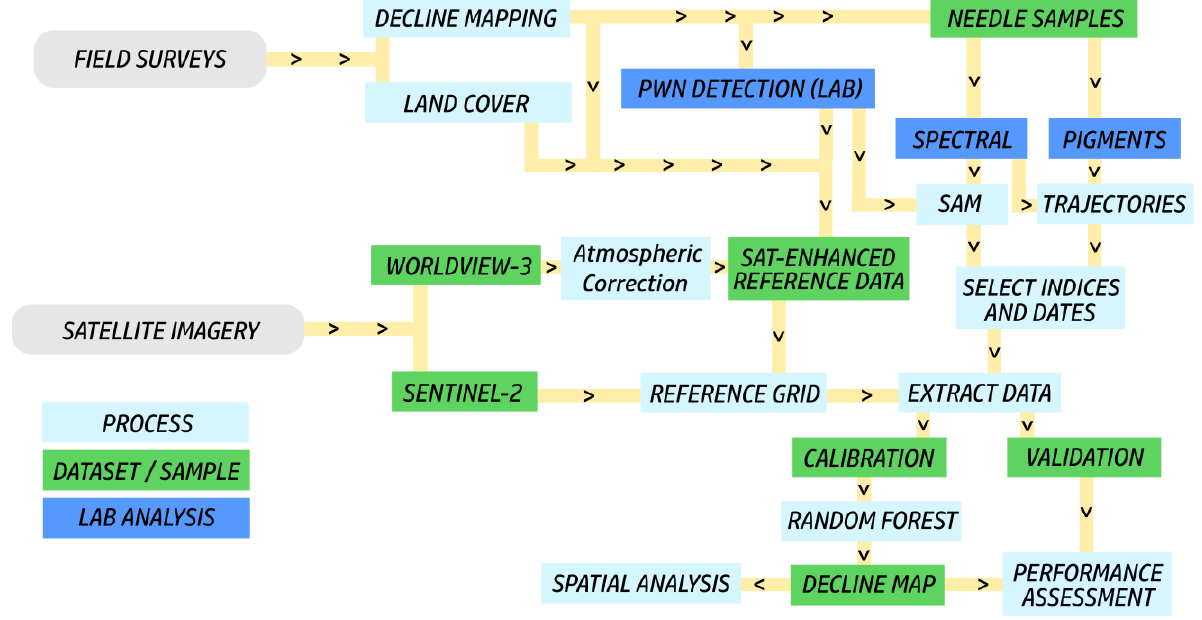
Figure 2. Workflow of the research project, which combines the analysis of field and satellite imagery for the development of a decline detection model focused on maritime pine occurring in Southwest Europe. PWN: Pinewood nematode; SAM: spectral angle mapper.